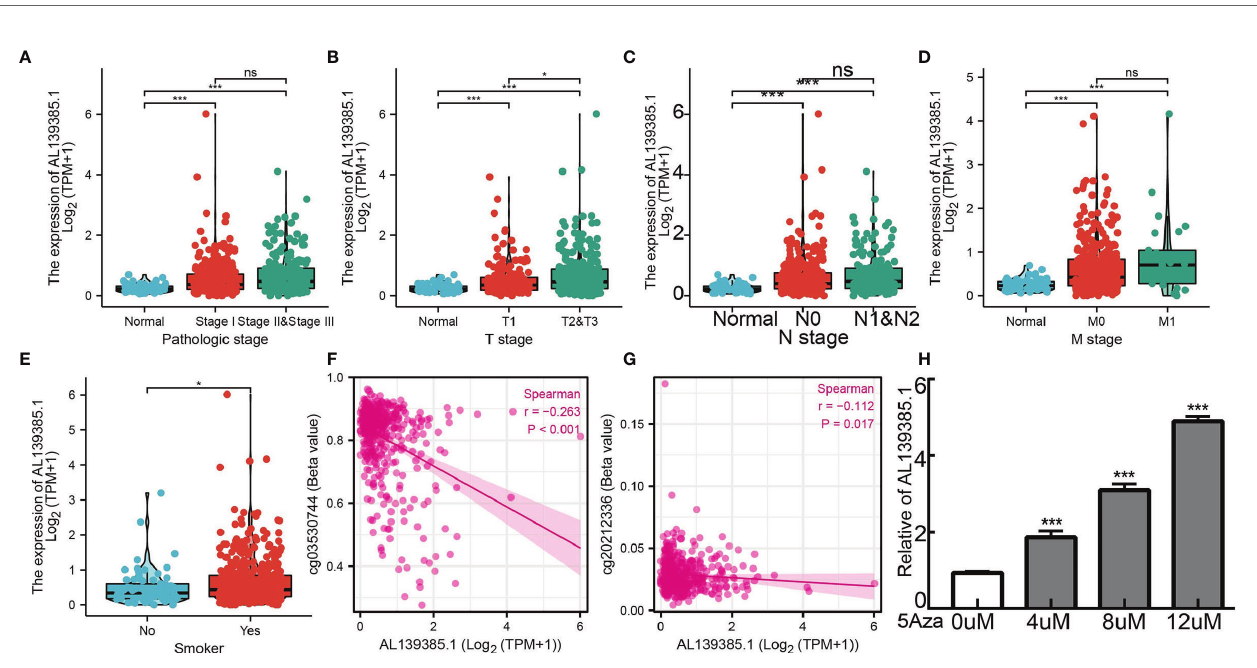
FIGURE 2 | Analysis of the clinical signi fi cance and DNA methylation of AL139385.1 in lung adenocarcinoma. Correlation with AL139385.1 expression and clinicopathologic characteristics, including (A) pathological stage, (B – D) TNM stage and (E) smoking. (F, G) AL139385.1 expression negatively correlates with mean AL139385.1 promoter methylation levels in TCGA LUAD cohort. (H) AL139385.1 expression in A549 cells was signi fi cantly upregulated in a dose-dependent manner after 5-azacytidine treatment. NS: P> 0.05, *P<0.05, and